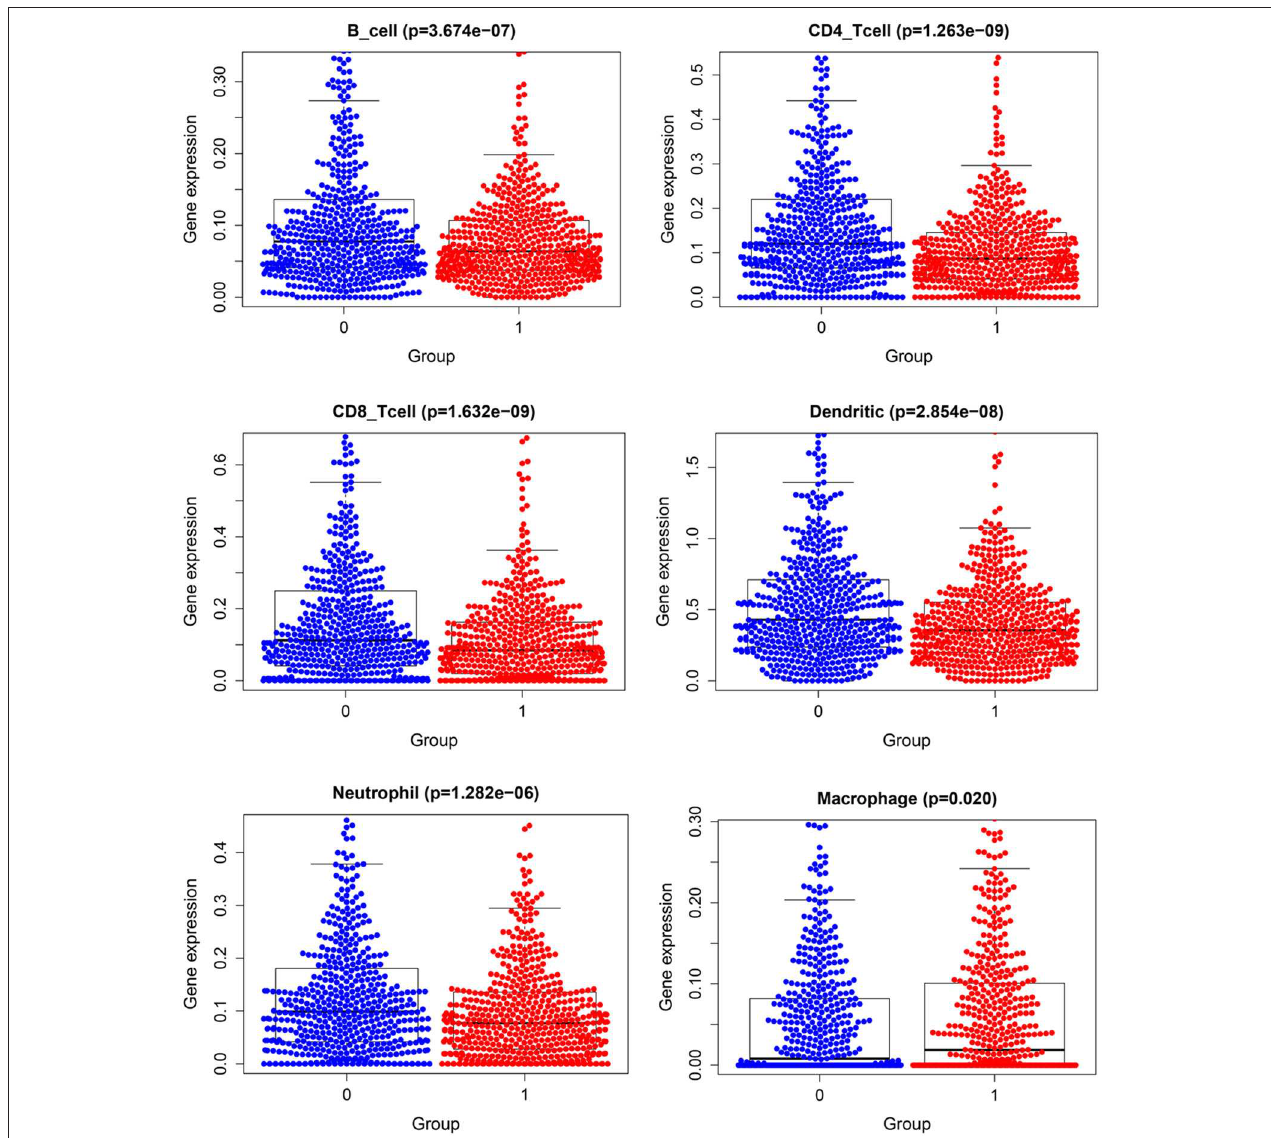
FIGURE 11 | Expression of tumor immune–infiltrating cells.